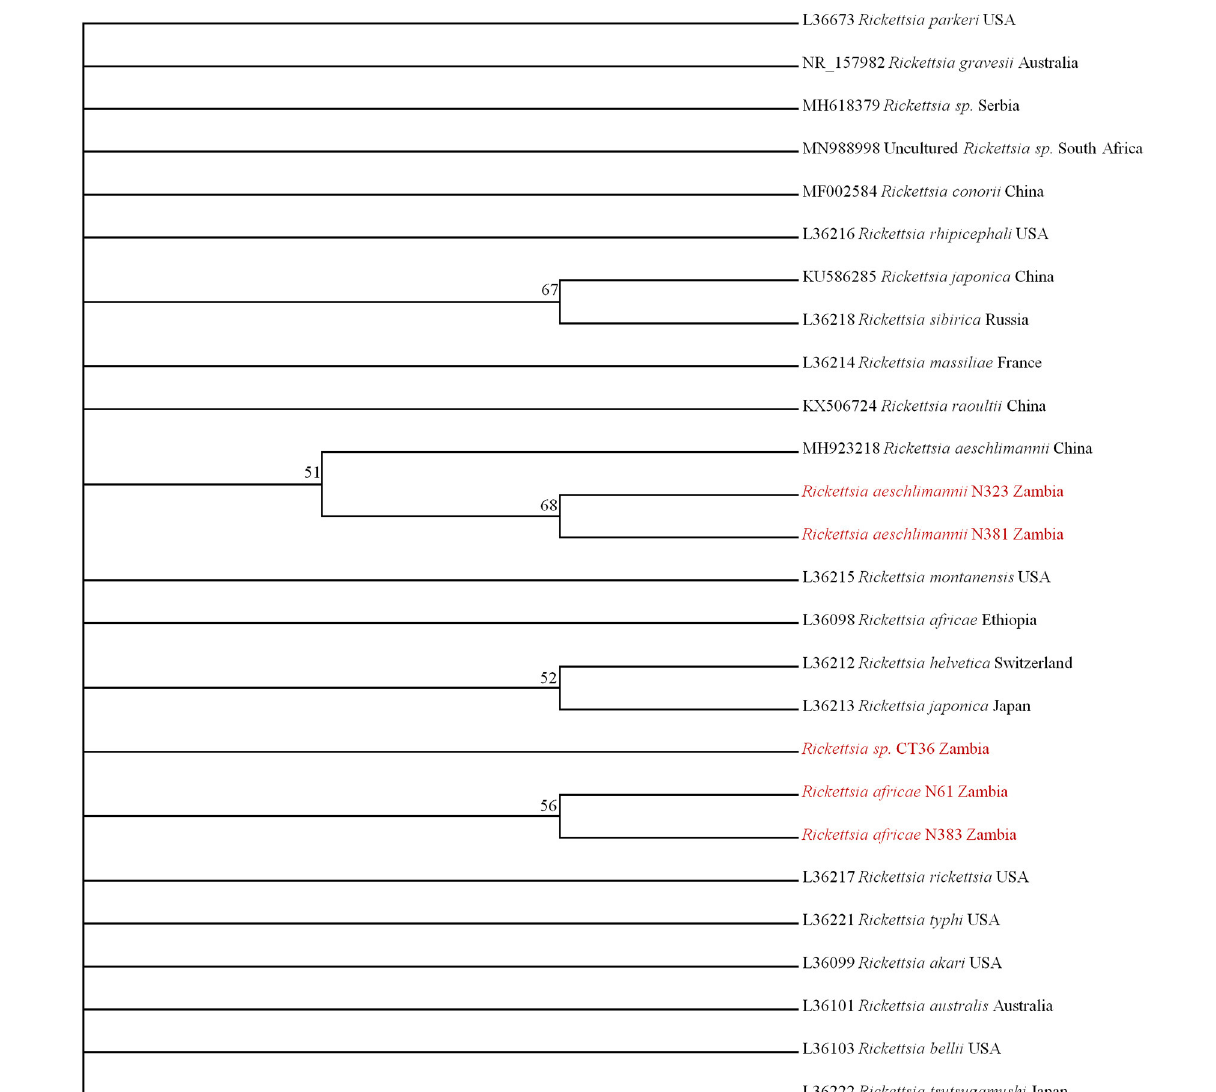
FIGURE 3 | Phylogenetic relationships of the 16S rRNA genes of rickettsiae detected in ticks in Zambia. Phylogenetic analysis was based on 795 bp of the 16S rRNA gene. Numbers at branch nodes indicate bootstrap values ≥ 50%. The reference sequences included in the analyses are shown by their GenBank accession number, species, and country of origin. The Rickettsiae characterized in the present study are in red